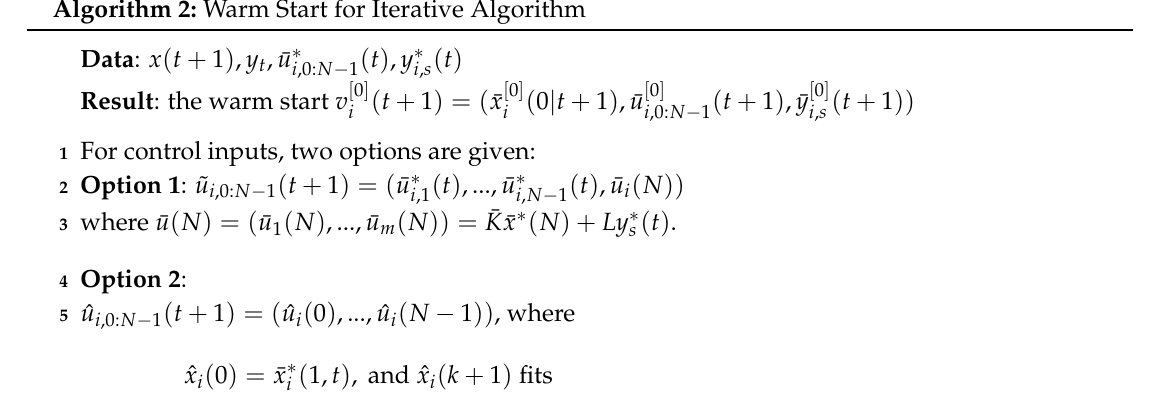
Algorithm 2: Warm Start for Iterative